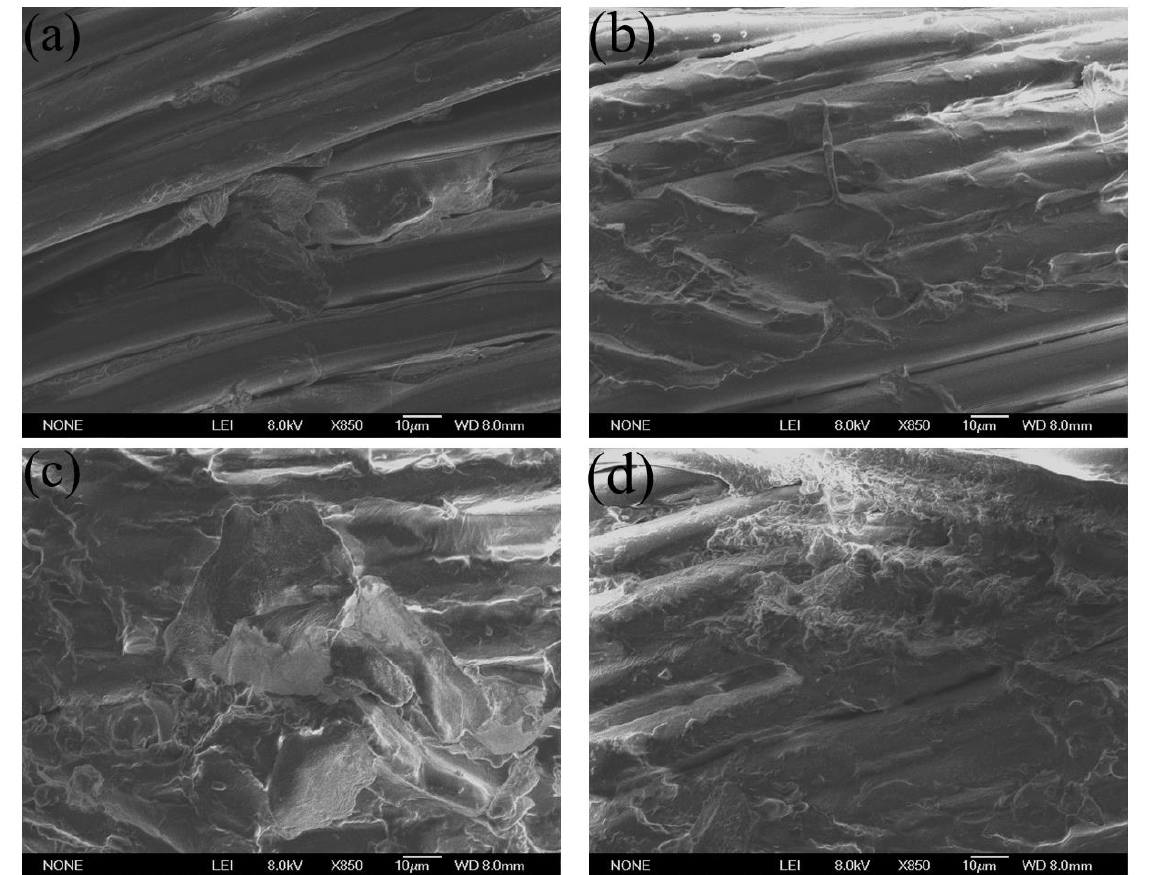
Figure 9. SEM images of PET/SBR composites impregnated with CFL emulsion. ( a ) C/F = 1/1.2, ( b ) C/F = 1/1.6, ( c ) C/F = 2.0, ( d ) C/F = 1/2.6.